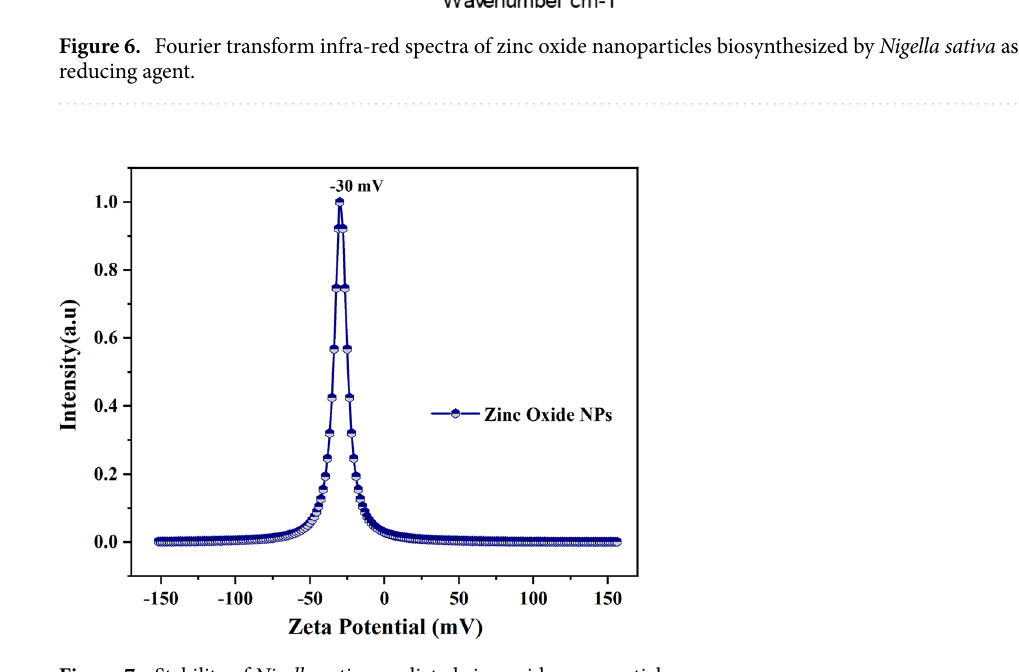
Figure 7. Stability of Nigella sativa mediated zinc oxide